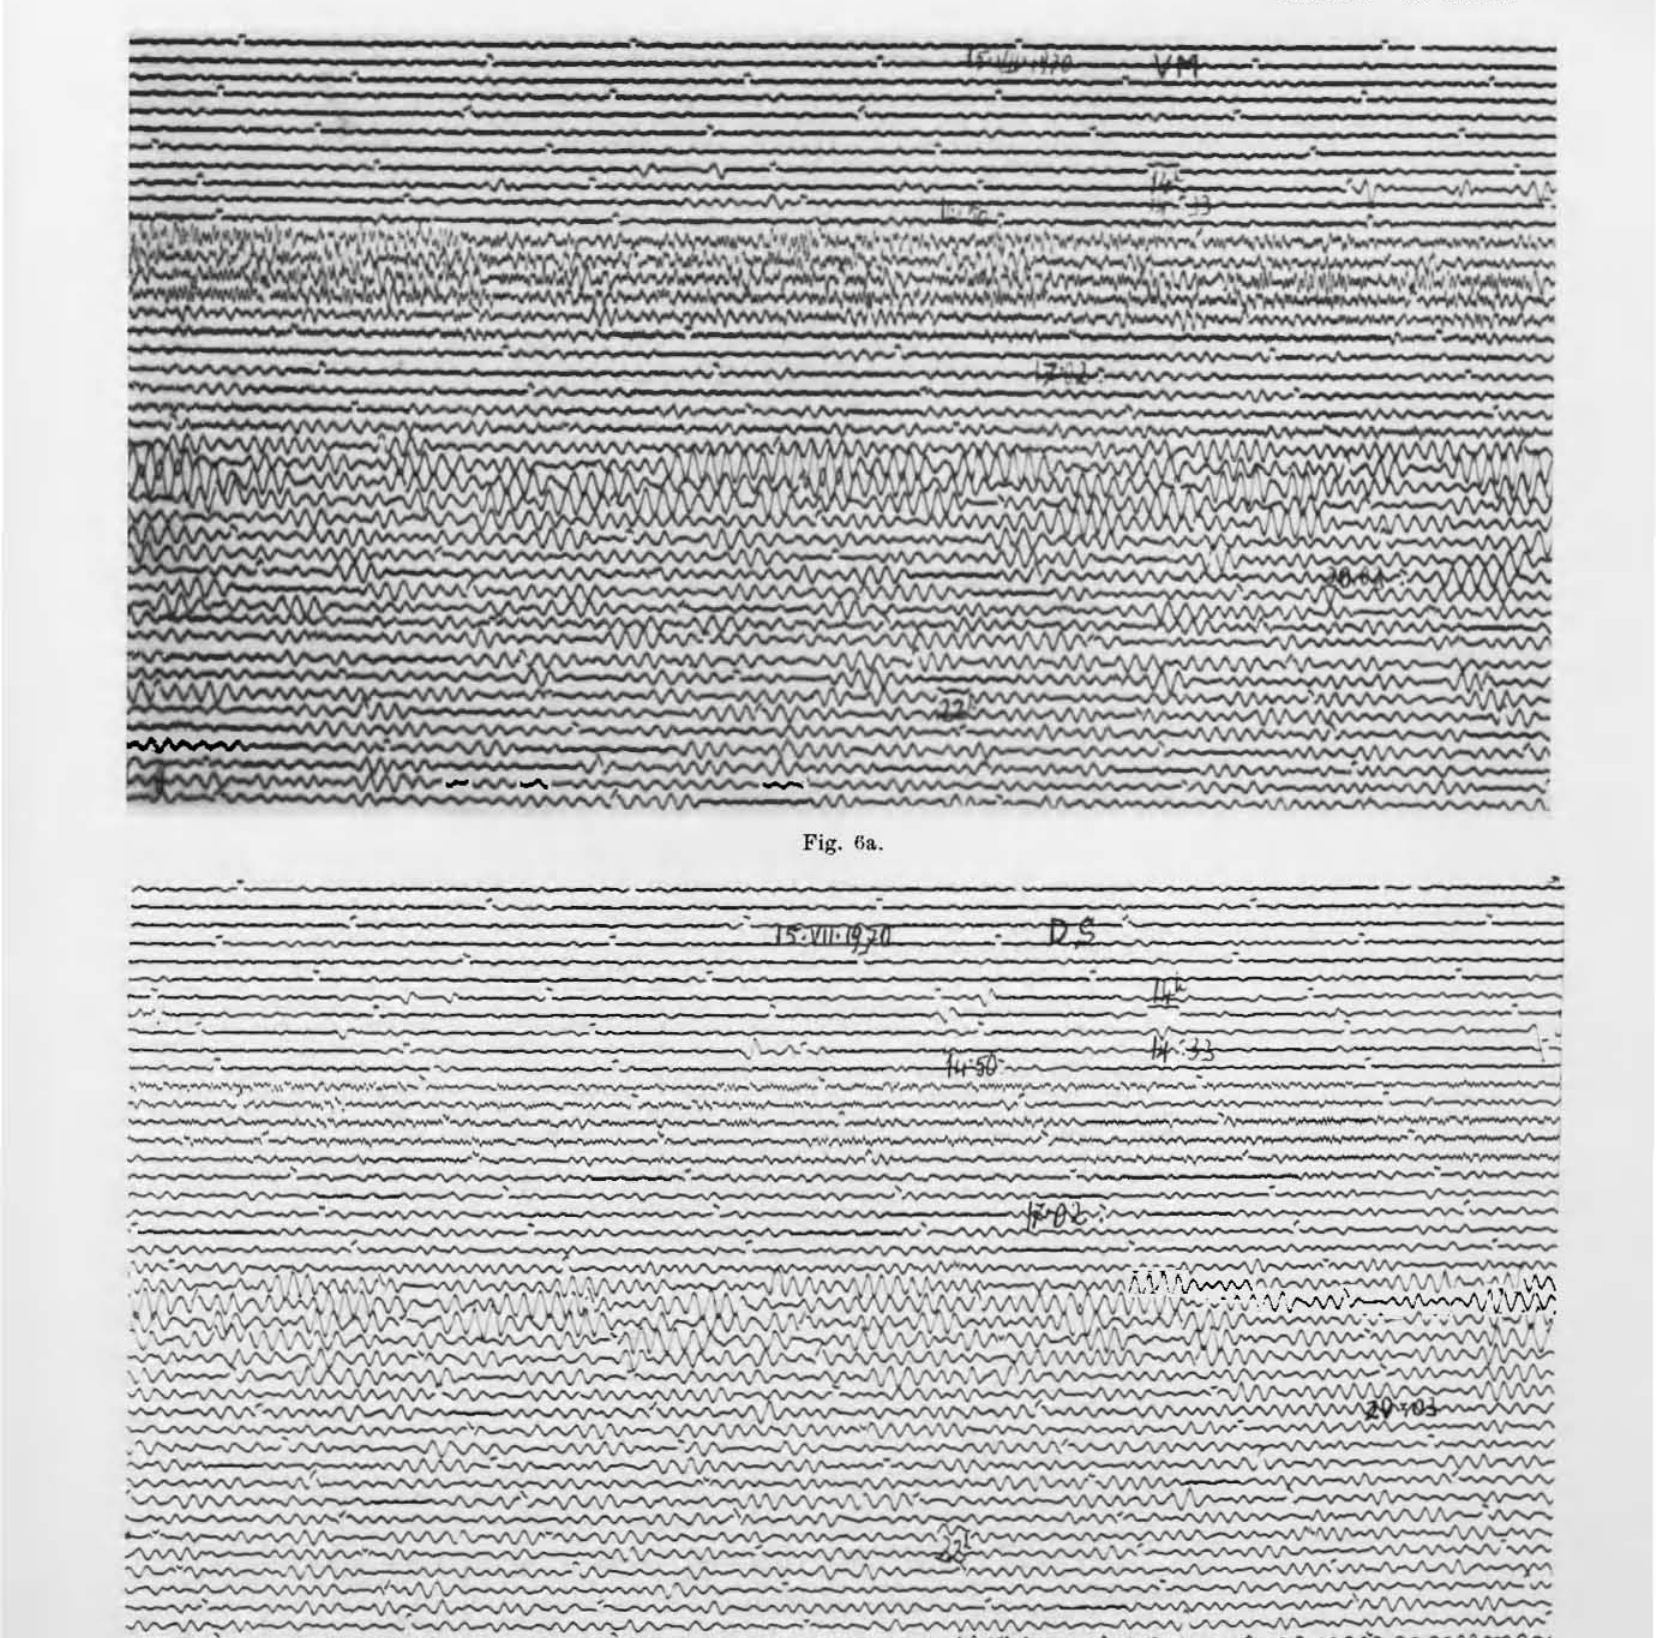
Fig. 6 _ Registrazione di microsi~mi ottenuti a Pieve di Cadore, sul lago omonimo, asgociati al transito (lei ciclone del 15. VI 1.1970, Si Ollserva,110 due (u.~i (lisUnte: Ulla (10.110. 14h40m ca (T.M.G.) alla 16 h GOm ea~ l'altra dalle 1711.30 111 ca in poi. La prima fase - la più